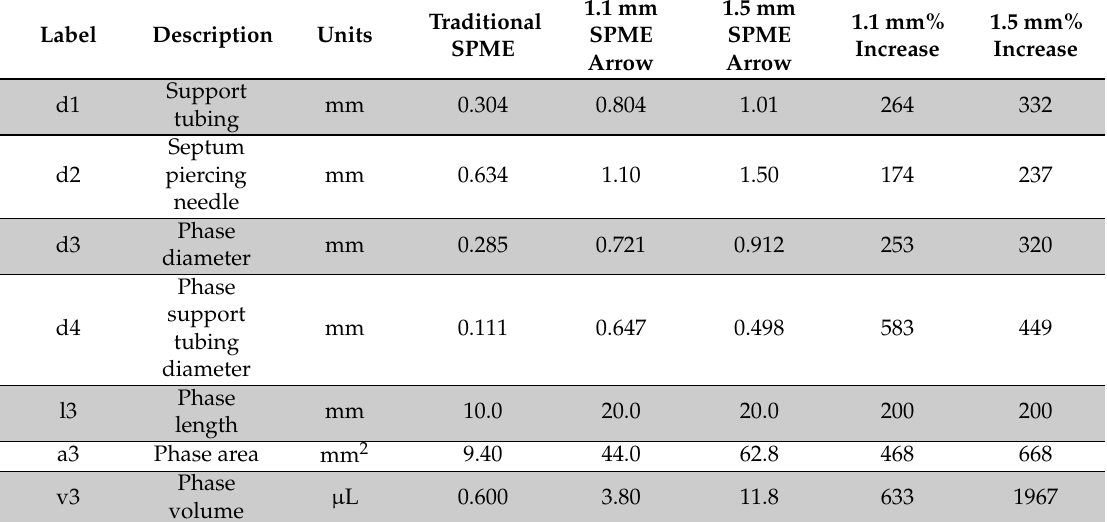
Table 1. Dimension breakdown of 23 gauge traditional SPME fiber (100 µ m